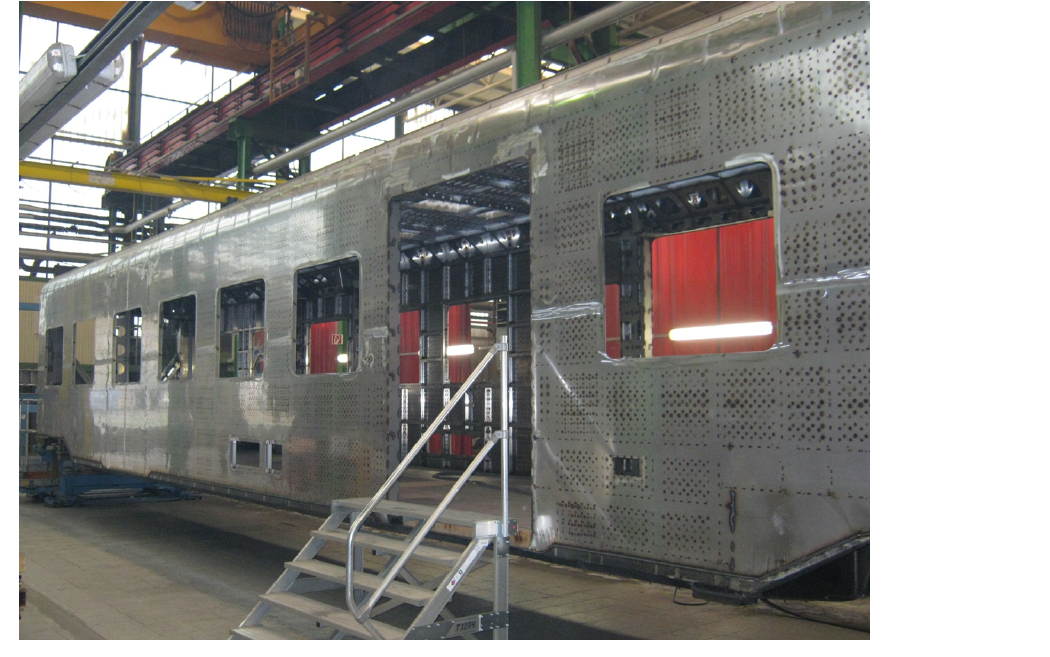
Figure 1. A car body shell as an example of a test object in a test rig.